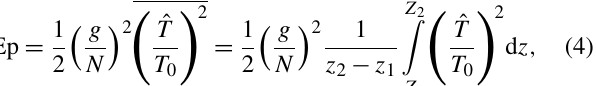
(cid:16) g (cid:17) 1 N 2